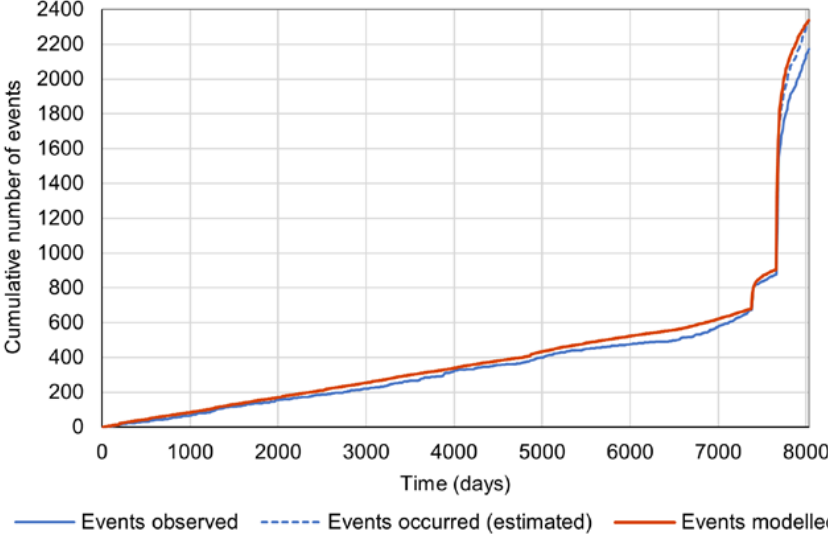
Figure 6. Modelled versus observed event accumulation in the study period 2000–2021 for M ≥ 2.5. The two large event surges late in the period correspond to the Zagreb and Petrinja, Croatia, 2020–2021 earthquake sequences. The model estimates that 155 occurrences in the Petrinja aftershock sequence are missing from the observed catalogue. Additionally, it is worth noting the step-up of the back- ground rate from day 6576 (1 January 2018), which is the beginning of the period when the study area covers the extended